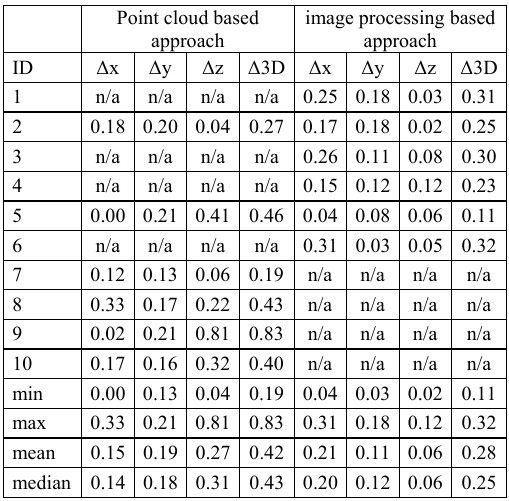
Table 3. Difference between reconstructed nodes and